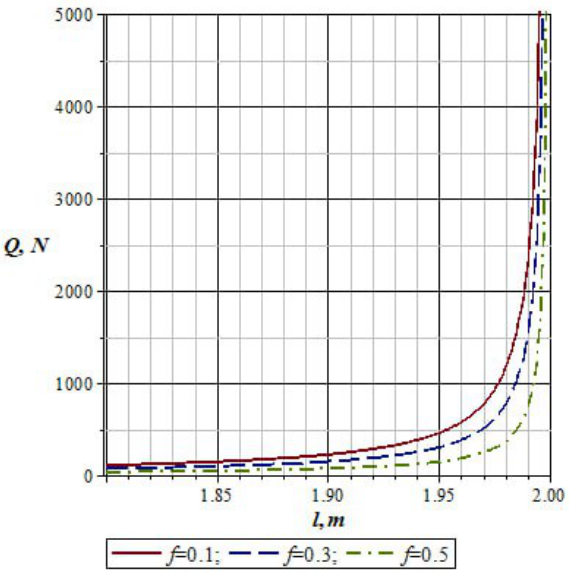
Figure 10. Graph of changes in the pressure of the working rolls depending on the length of the lever l 2 .